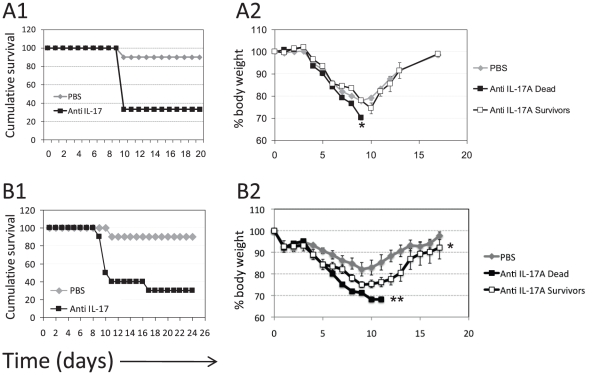
The effect of anti IL-17A antibody administration on response to intranasal LVS infection.(A) WT C57BL/6 mice were infected with 100 CFU (0.1×LD50). Mice were then injected with 100 µg of neutralizing anti IL-17A mAb (n = 6 animals) or with carrier only (n = 10 animals) on days 0 and 7 post infection. (A1) depicts the cumulative survival of the two experimental groups, P value <0.05; (A2) depicts body weight monitoring of PBS-treated mice (gray diamonds), mAb-treated mice that eventually died (black squares, n = 4 animals) or recovered of the disease (white squares, n = 2 animals). Figure shows one experiment out of two performed (with similar results); (B) WT C57BL/6 mice were infected with 30 CFU. Mice were then injected with 100 µg of neutralizing anti IL-17A mAb (n = 10 animals) or with carrier only (n = 10 animals) on days 0 and 7 post infection. (B1) depicts the cumulative survival of the two experimental groups, P value <0.01; (B2) depicts body weight monitoring of PBS-treated mice (gray diamonds), mAb-treated mice that eventually died (black squares, n = 7 animals) or recovered of the disease (white squares, n = 3 animals). Figure shows one experiment out of two performed (with similar results). *denotes P value <0.05; ** denotes P value <0.01.